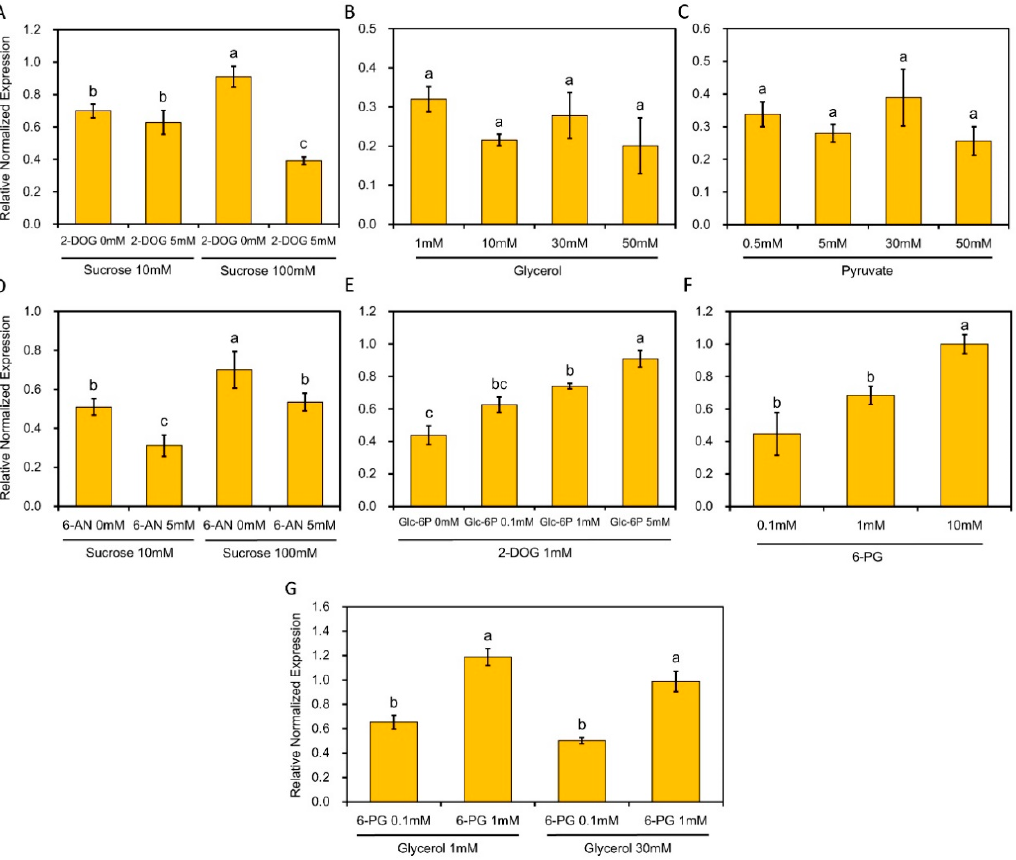
Figure 6. The transcript level of RhPUF4 is slightly responsive to glycolysis/the TCA-cycle, but highly sensitive to the OPPP in in-vitro-cultured buds. ( A , D ) Transcript levels of RhPUF4 in buds treated with 10 mM and 100 mM sucrose in the presence or in the absence of 5 mM 2-DOG or 6-AN, respectively; ( B , C ) transcript levels of RhPUF4 in buds treated with different concentrations of glycerol or pyruvate, respectively; ( E ) transcript levels of RhPUF4 in buds treated with 1 mM 2-DOG and different concentrations of glucose-6-phosphate; ( F ) transcript levels of RhPUF4 in buds treated with different concentrations of 6-PG. ( G ) Transcript levels of RhPUF4 in buds treated with different combinations of glycerol and 6-PG. Glc-6P, glucose-6-phosphate; 6-PG, 6-phosphogluconate. Data are means ± SEs of three replicates. The letters indicate significant differences between the different treatments with p < 0.05.